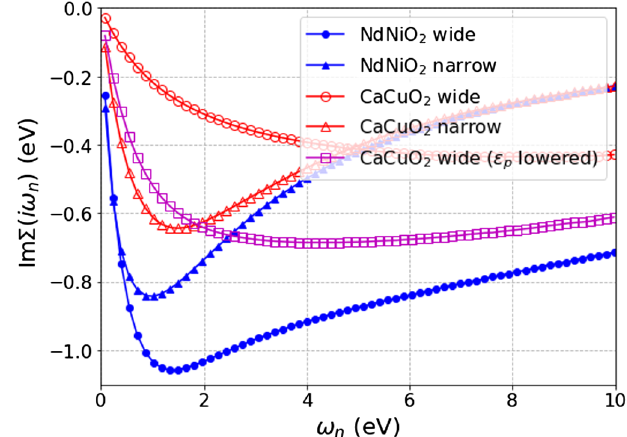
FIG. 2. Imaginary part of the Matsubara self-energy for the d orbital for NdNiO 2 (blue, filled symbols) and CaCuO 2 (red x 2 − y 2 and magenta, open symbols) at T ¼ 290 K, for both the wide energy window with U ¼ 7 eV (circles) and the narrow energy window with U ¼ 3 . 1 eV (triangles). Also shown is the wide energy window result for CaCuO 2 with ε (squares, referred to in the legend as “ ε